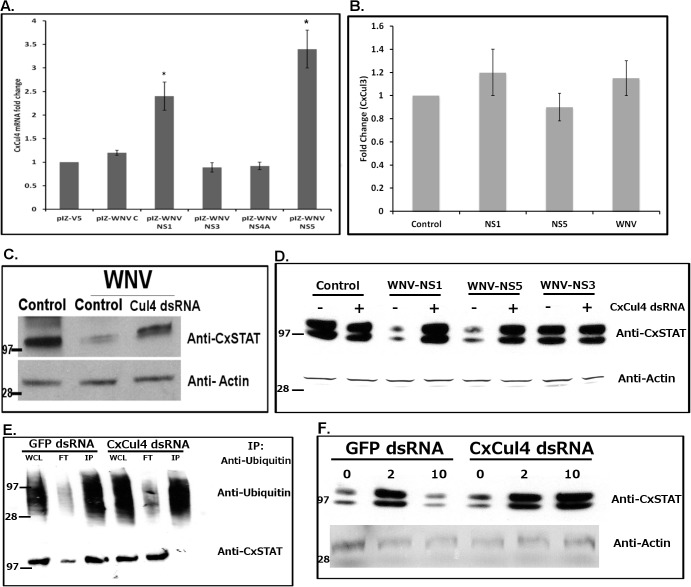
WNV NS1 and NS5 are responsible for CxCul4 regulation.
A. Hsu cells were transfected with WNV genes (C-Capsid; NS1, NS3, NS4A or NS5). Total RNA was collected at 24 hours post-transfection and real time RT-qPCR was performed using Culex Cul4-specific primers. RpL32 primers were used as internal control. Error bars represent standard error from three separate experiments with assays performed in triplicate (Student’s t-test *p < 0.05, significant from empty vector control). B. Real time Rt-qPCr was performed on cells treated as in A, using Culex Cullin3-specific primers. C. Hsu cells were transfected with dsRNA against Culex cullin (Cul4 dsRNA). GFP dsRNA was used as a silencing control (Control). At 24 h post-transfection, the cells were infected with WNV and cell lysates were collected 24 hours post-infection. Western blot was performed using anti-Culex STAT and anti-beta actin antibodies, with marker representing proteins with known molecular weight (in kDa). The experiment was repeated 3 times and representative blots shown here. D. Hsu cells were transfected with WNV genes (NS1, NS5 or NS3) along with dsRNA against Culex cullin (+). GFP dsRNA was used as a silencing control (-). Control indicates empty vector transfection. Cell lysates were collected 24 hours post-infection. Western blot was performed using anti-Culex STAT and anti-beta actin antibodies. The experiment was repeated and representative blots shown here. E. Hsu cells were transfected with dsRNA against Culex cullin (Cul4 dsRNA). GFP dsRNA was used as a silencing control (GFP dsRNA). At 24 h post-transfection, the cells were infected with WNV and treated with MG132 (1 μM) and cell lysates were collected 24 hours post-infection. Immunoprecipitation was performed using anti-ubiquitin antibody, followed by Western blot using anti-ubiquitin (Upper) and anti-CxSTAT (lower) antibodies. WCL represents whole cells lysate (pre-IP), FT represents flow-through and IP represents immunoprecipitate (eluate). The experiment was repeated twice and representative blots shown here. F. Female Culex annulirostris mosquitoes were microinjected with dsRNA against Culex Cullin (Cul4). GFP dsRNA was used as a silencing control. At 24 h post-injection, mosquitoes were blood-fed with WNV for 1h. At 2 days and 10 days post-infection, mosquitoes were collected and processed for Western blot using anti-CxSTAT and anti-actin antibodies. The experiment was repeated and representative blots shown here.